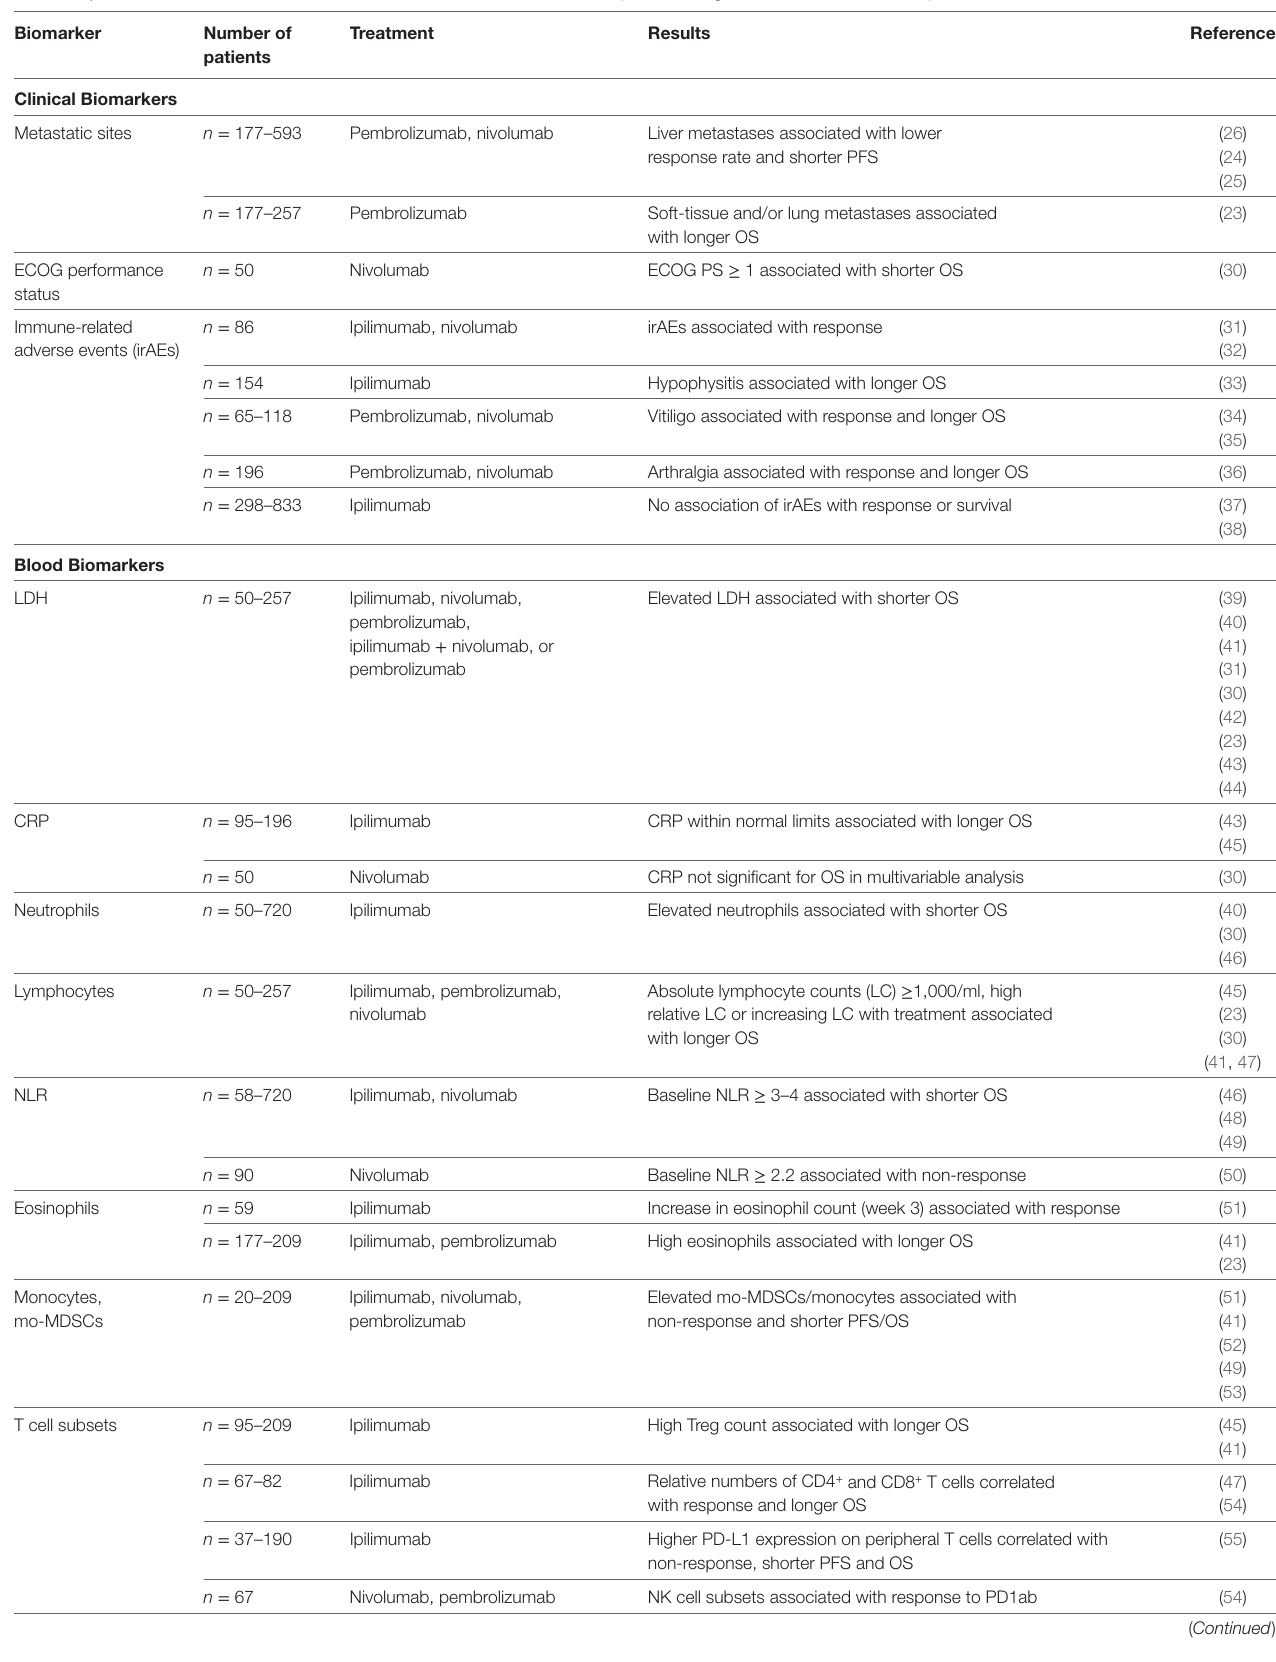
TABLe 1 | Clinical, blood, and stool biomarkers for clinical outcome under checkpoint blockage for metastatic melanoma